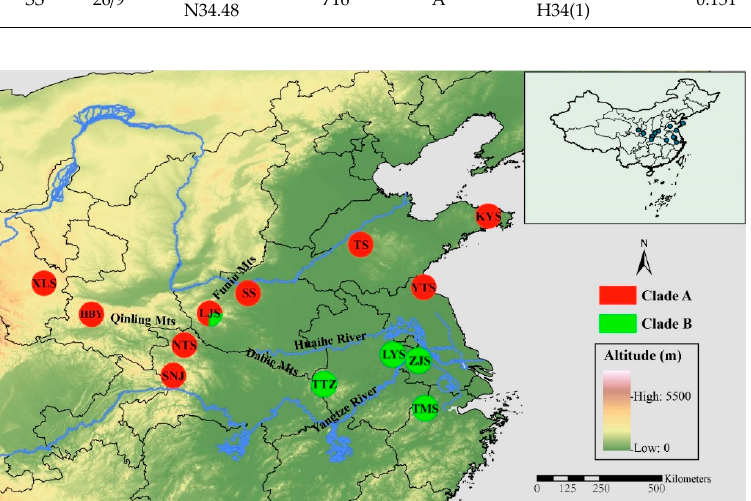
Figure 1. Geographic distribution of the 13 sampled populations of Parnassius glacialis . Populations are represented by pie charts with slice size proportional to the frequency of mitochondrial DNA (mtDNA) haplotype clades (see text for explanation). Pie chart size corresponds to the clades in Table 1. Table 1. P. glacialis population genetic parameters and sample data. (N, Sample size subjected to mtDNA/SNP examination; “H”, for mtDNA haplotype; Clade A/B as shown in Figure 3).